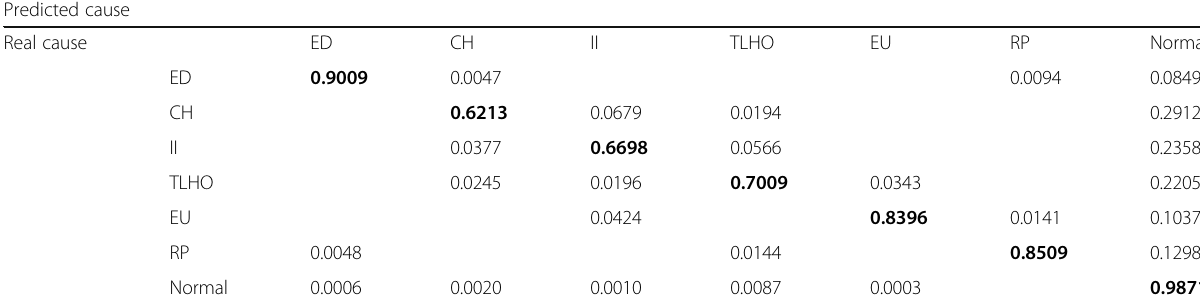
Table 2 Normalized confusion matrix of AdaBoostLSVM method with optimal parameter values Predicted cause